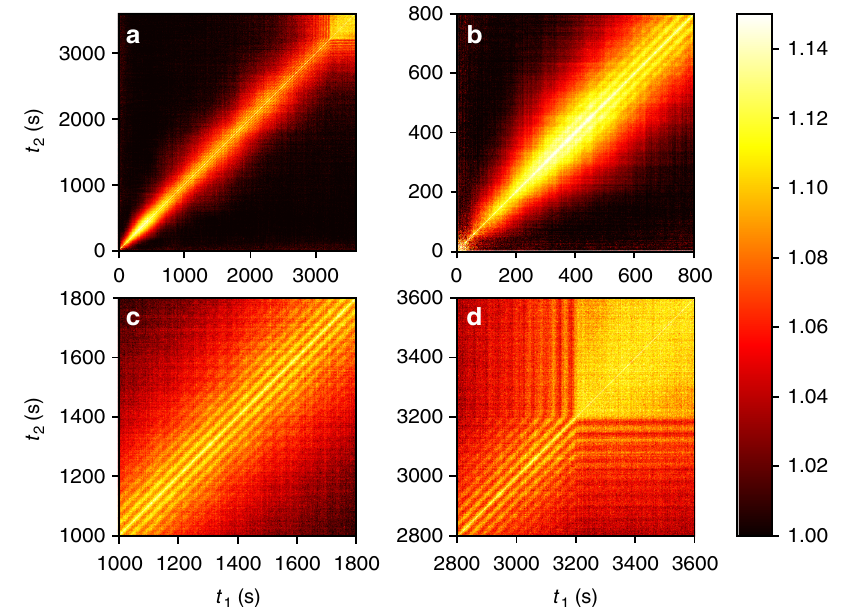
Fig. 2 Two-time correlations for C 60 deposition on graphene/SiO 2 . a The complete 1-h data collection during deposition with a substrate temperature of 144 °C. The deposition shutter was opened at 40 s. after the start of the scan and closed again at 3200 s. b detailed view of the early time island nucleation and transition to local step- fl ow growth. c close-up during the middle of the scan with stationary dynamics. d view of the end of the deposition, showing that the dynamics stop abruptly when the growth shutter is closed. The data was collected at Q || = 0.0115 Å − 1 and Q z = 0.045 Å −